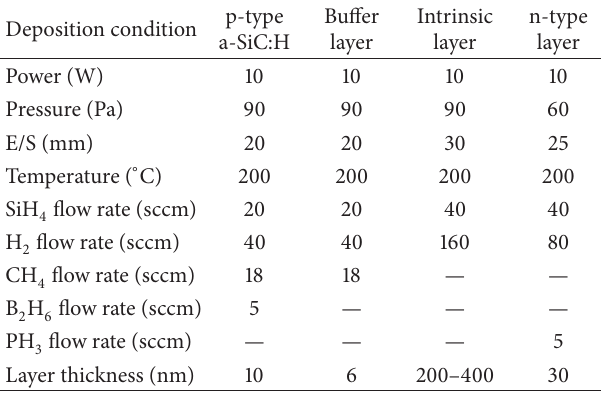
in Table 2 in comparison with a-Si:H. In Table 2, the values of the left column (a-Si:H) were obtained from [15]. The values of the right column (a-Si:H-like) were measured from our experimental films. The crystallinity was evaluated by micro- Raman spectroscopy. The dark conductivity was measured at room temperature using a source-measure unit (KEITHLEY 2400). The photoconductivity measurement was carried out under AM1.5G (100 mW/cm 2 ) of a solar simulator. The defect density was obtained by electron spin resonance